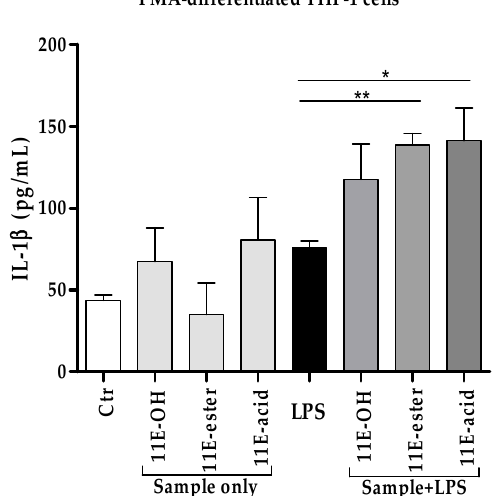
Figure 4. Effect of eicosenoid compounds on the production of IL-1 β by phorbol 12-myristate 13-acetate (PMA)-differentiated THP-1 cells in the absence and presence of LPS (0.5 µg/mL). The IL-1 β levels were significantly enhanced in 11E-ester and 11E-acid combination treatments when compared with LPS alone ( n = 3). Ctr: Untreated control; LPS: Lipopolysaccharide; (11E-OH): (Z)-11-eicosenol; (11E-ester): Eicosenoate; (11E-acid): Eicosenoic acid; *: Significant ( p < 0.05); **: Significant ( p < 0.01).